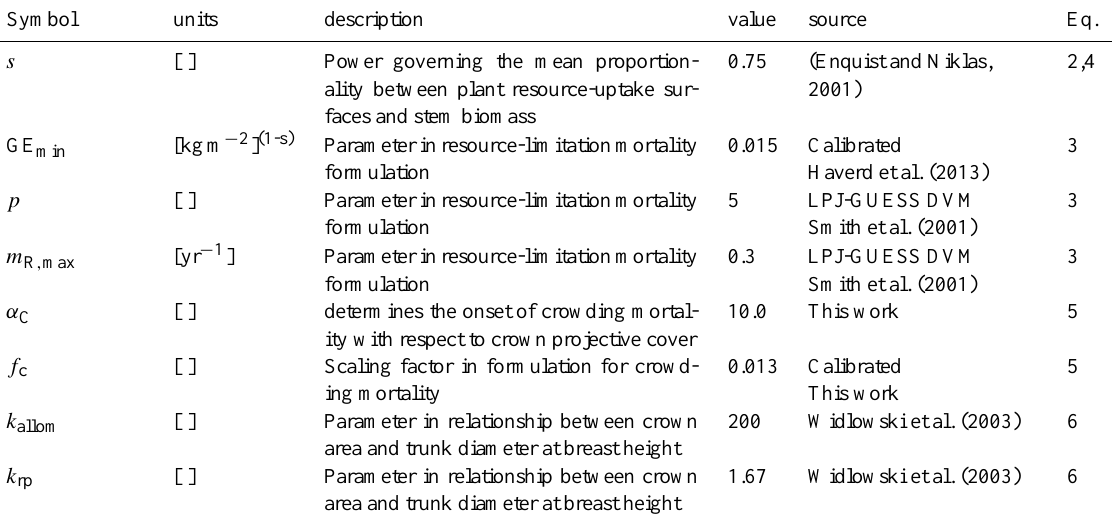
Table 1. POP model parameters.